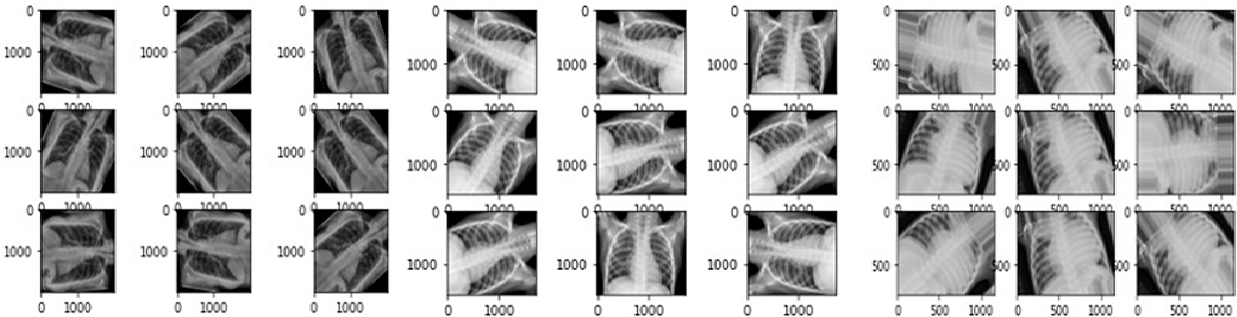
Figure 6. State of images after rotation augmentation.